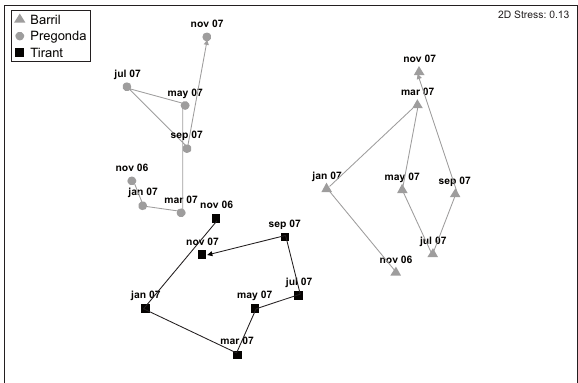
Fig . 3. – MDS ordination of the samples showing centroids for each study site and sampling time (n = 3). Seasonal trajectories are indi- cated by arrows for each study